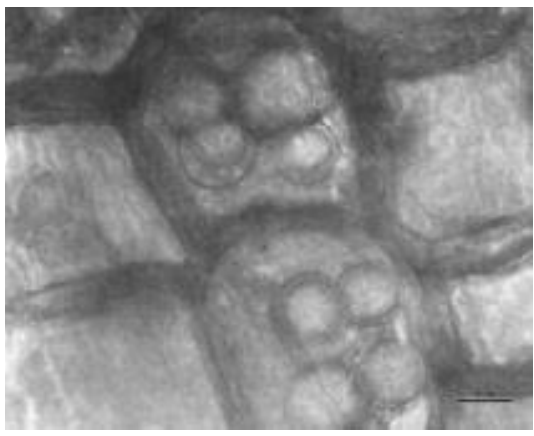
Figure 1. Chlamydospores of S. indica in highbush blueberry root. Bar represents 10 µm.